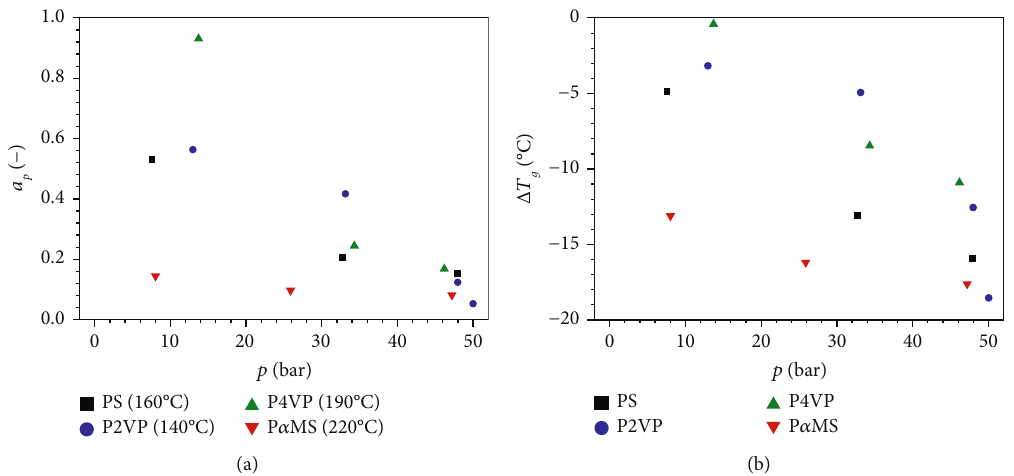
ð p Þ / η ð 1bar Þ of the steady-state viscosity η s s